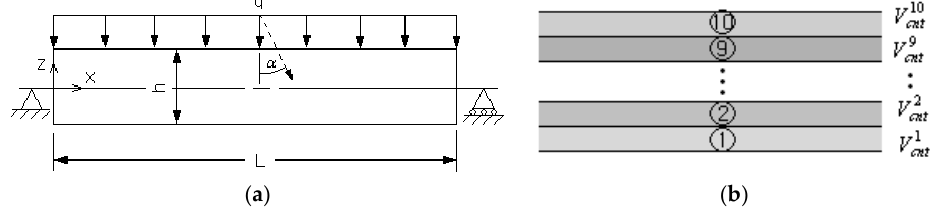
Figure 4. A simply supported FG-CNTRC beam: ( a ) geometry and dimensions, ( b ) uniform sub-layers. Table 2. Material properties of SWCNT and matrix